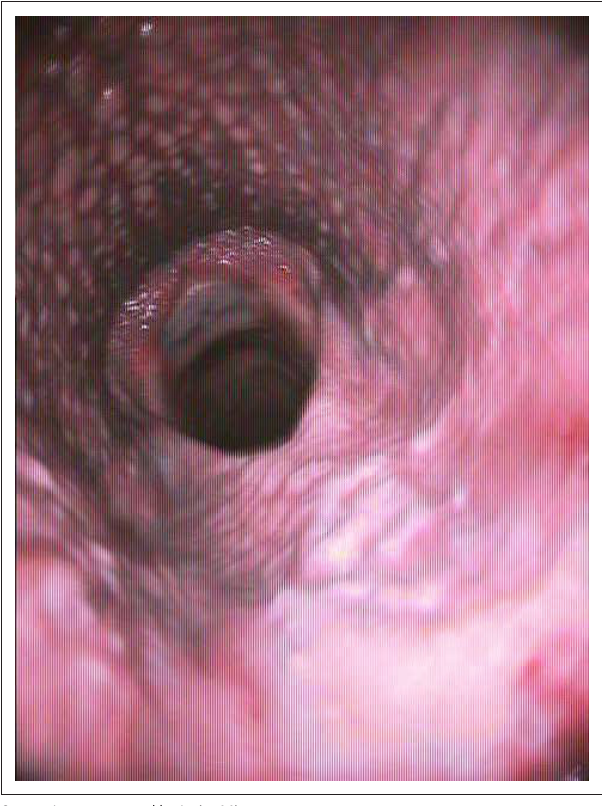
FIGURE 7: Single abnormality observed in the study: Dorsal displacement of the soft palate.